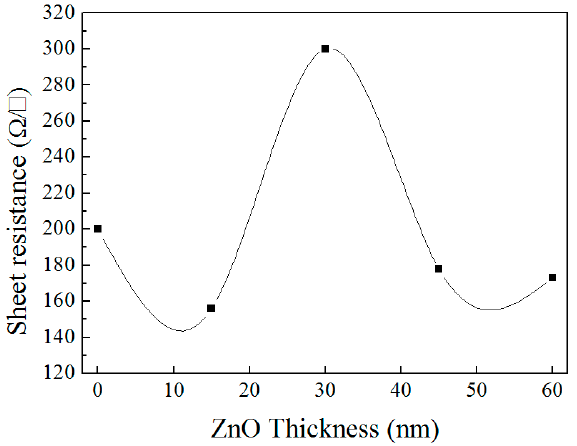
Figure 16. The sheet resistance of ZnO/Cu 2 S/glass complex films for different thickness.